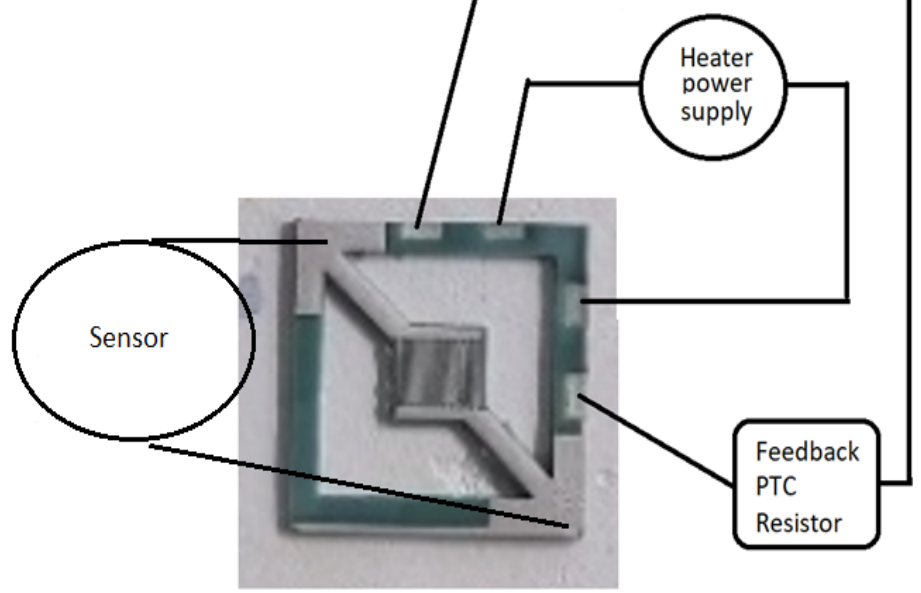
Figure 5. Heater, sensing area, and PTC resistor connections within the ceramic.